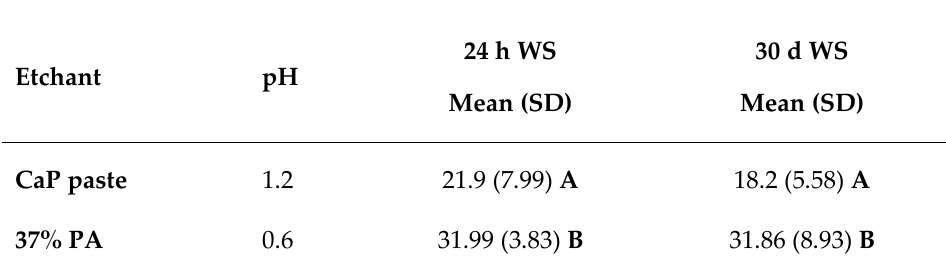
Table 1: pH and SBS (MPa) values of the control and experimental etchants after 24 h and 30 d WS.